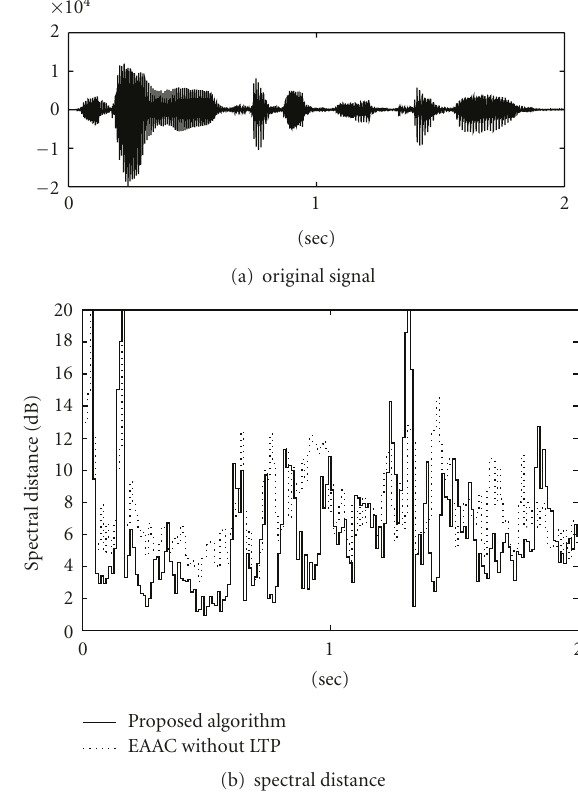
Figure 10: Spectral distance of speech